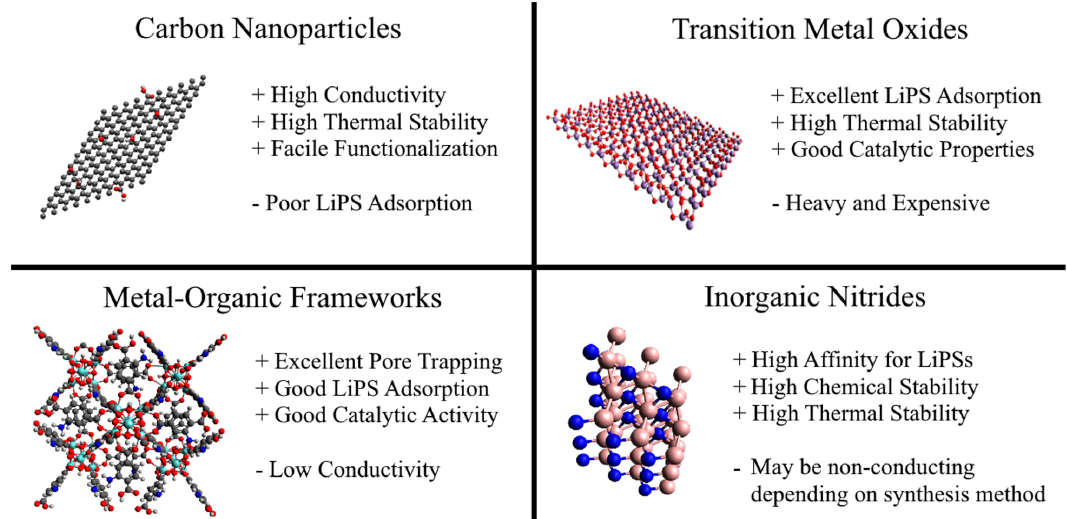
Figure 7. Schematic showing the basic structure of carbon nanoparticles, transition metal oxides, MOFs, and inorganic nitrides. The advantages (+) and disadvantages (-) are summarized.